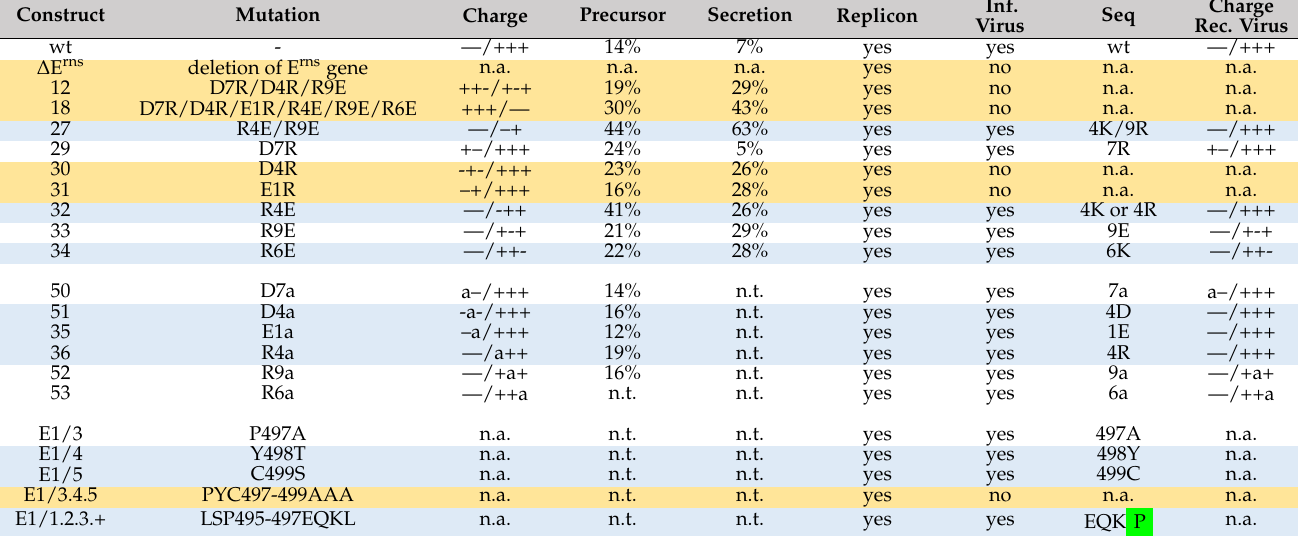
Table 1. Summary of the results of experiments conducted with the infectious CSFV cDNA clone. Column 1 lists the number of the individual mutant (same as in the Figures). Column 2: amino acid exchanges encoded by the construct (see legend to Figure 3 for nomenclature of the mutations); Column 3: charge distribution (“a” represents exchange for